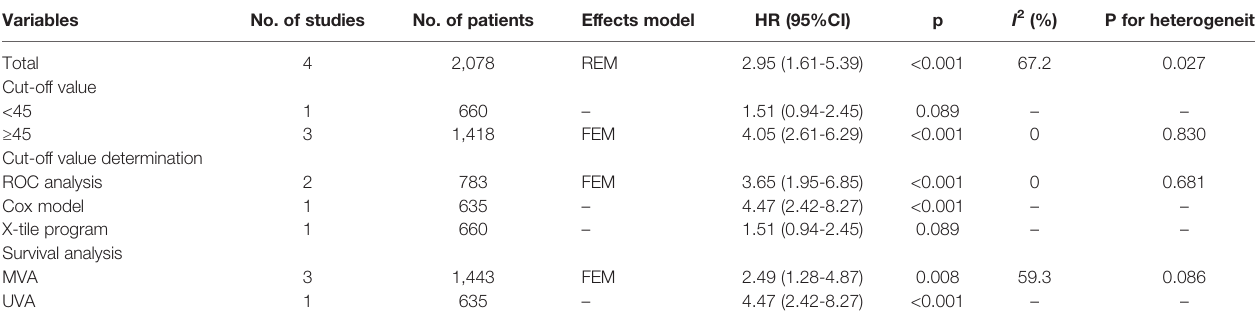
TABLE 5 | Results of subgroup meta-analysis for cancer-speci fi c survival.